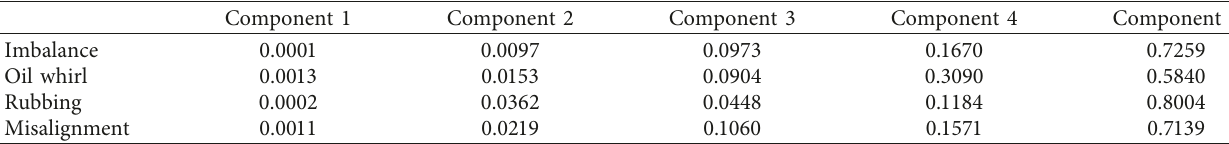
Figure 9: Oscillograms of four types of faults. (a) Imbalance. (b) Whirl. (c) Misalignment. (d) Rubbing. Table 2: Results of K-L divergence identification of four types of faults.